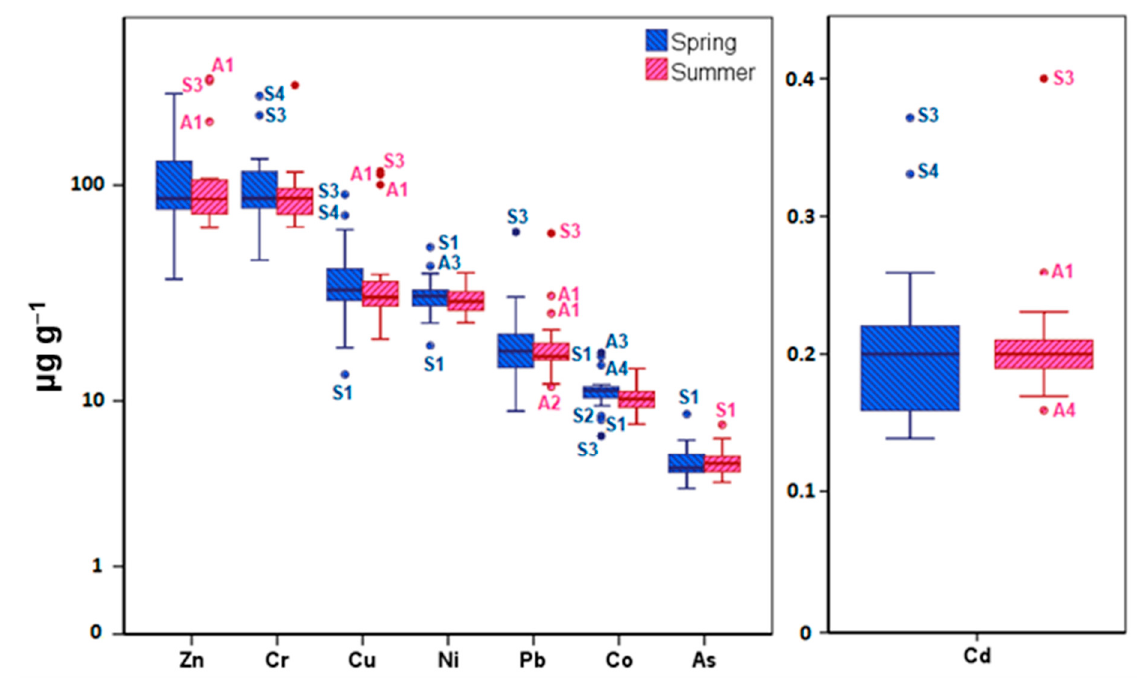
Figure 3. Box plot for trace metal concentrations in river sediments sampled in the Sebou basin during spring (blue box) and summer (pink box). The names of the stations are indicated for the outlier values (see Figure 1). Note that concentrations are expressed in log, except for Cd.